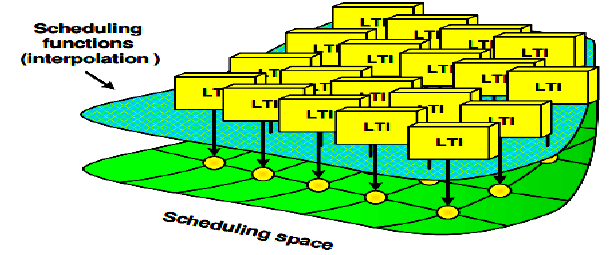
E Conventional PID Controller